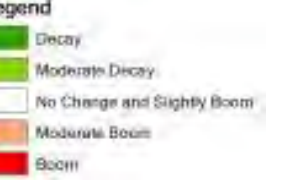
figure 3b Index change